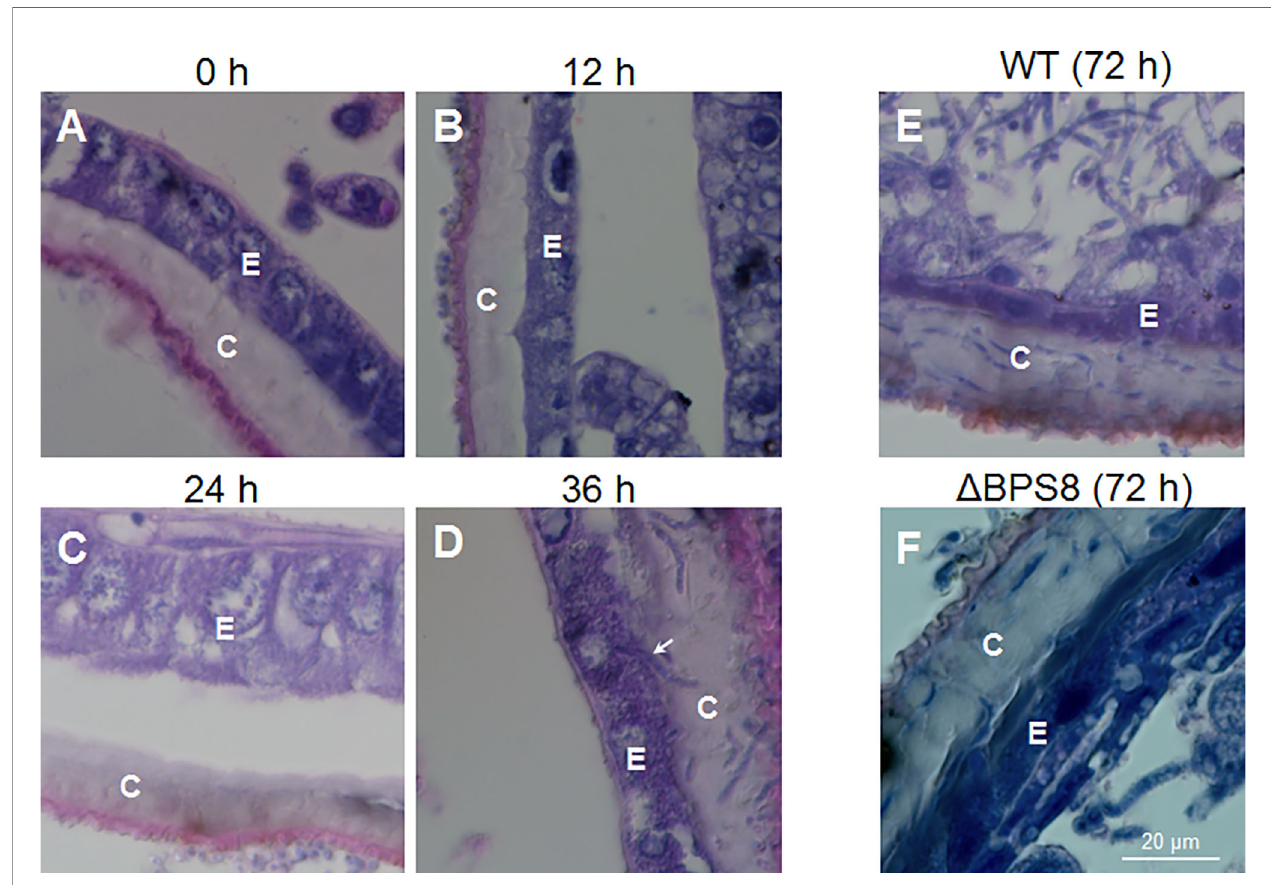
FIGURE 3 | B. bassiana hyphae inside the cuticle using light microscopy. After initiating the fi xed-site infection (1×10 8 spores/ml, the same with the following work unless otherwise mentioned), the integuments were sampled via tissue section and hematoxylin-eosin staining at different time points. BPS8 is a protease secreted by B. bassiana during germination (15) and conidia of the Δ BPS8 mutant (with BPS8 deleted) were also inoculated as above and sampled at 72 h. No hyphae were detected inside the cuticle within the fi rst 24 h (A – C) . Melanized cuticle was detected at 24 h (C) . At 36 h (D) , many hyphae inside the cuticle were clear and the arrow points to a hypha that was ready to penetrate the nucleus of an epidermal cell (D) . At 72 h (E) , the number of hyphae inside the cuticle increased and hyphae were detected in the hemocoel. At 72 h, only a few hyphae of Δ BPS8 were detected inside the cuticle (F) , which was fewer than wild type B . bassiana , and additionally few hyphae of Δ BPS8 were detected inside the hemocoel. In each picture, the small letter “ E ” and “ C ” represent epidermis cells and cuticle